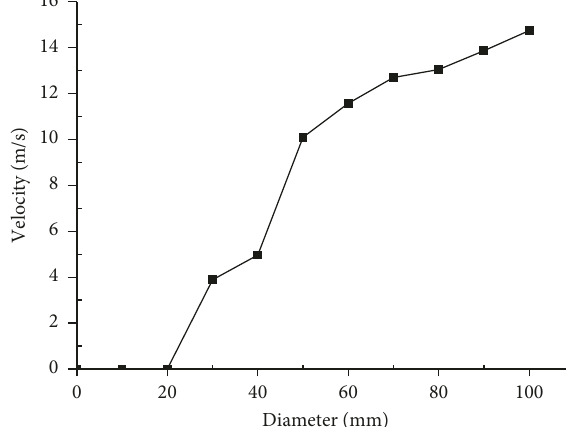
Figure 14: Changing curve of the final speed of sacked gangue with different vent